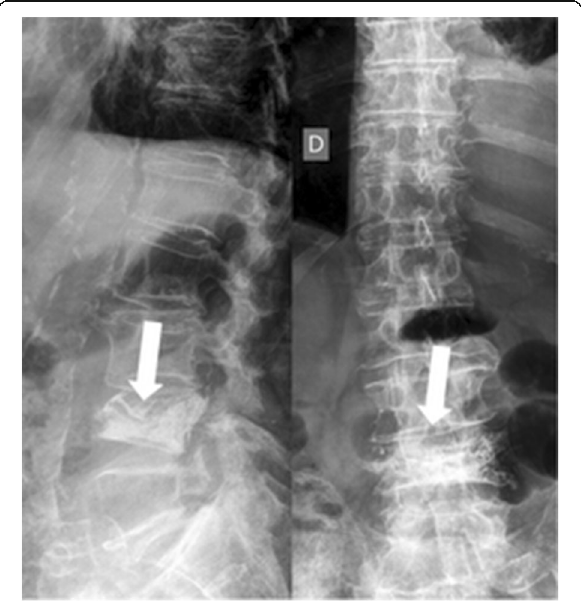
Fig. 3 Same case as shown in Figs. 1 and 2. Lumbosacral spine x-ray examination performed one month after the elastoplasty procedure demonstrating the good filling of L4 vertebral body (arrows). No evidence of new vertebral fractures is